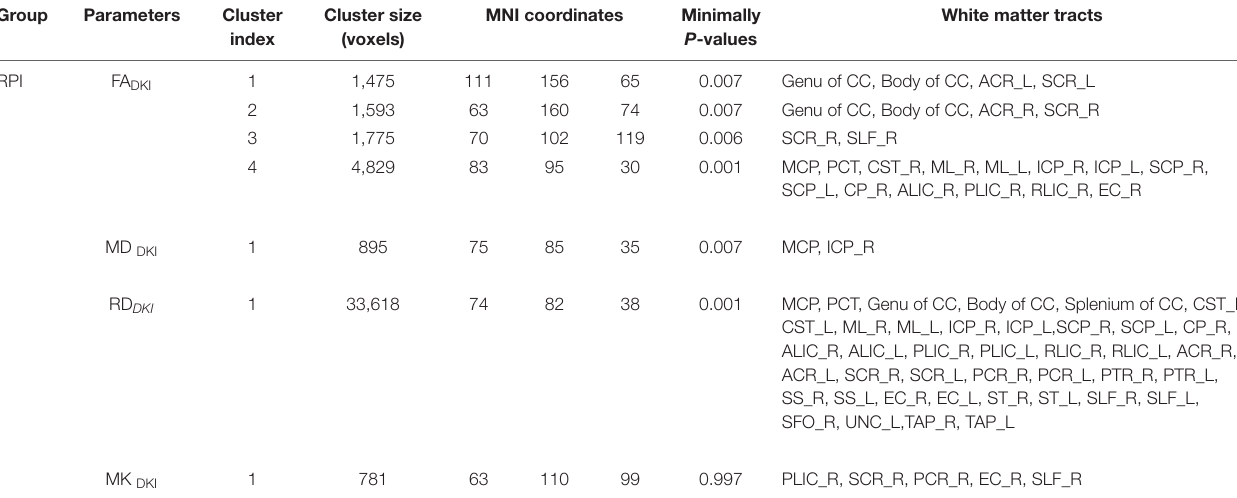
TABLE 5 | Abnormal white matter fibers derived DKI different parameters in the RPI group.